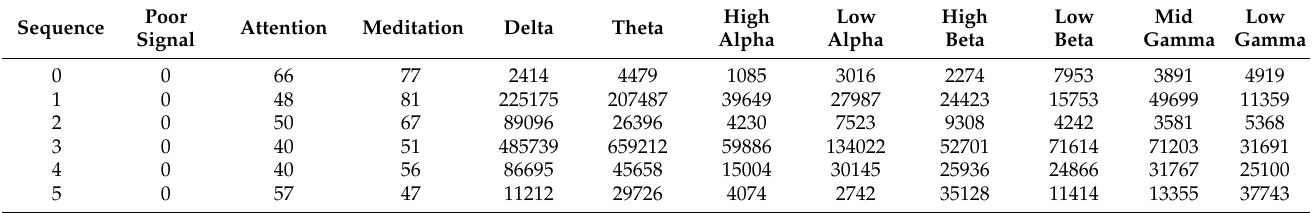
Table 6. Derived EEG powers dataset